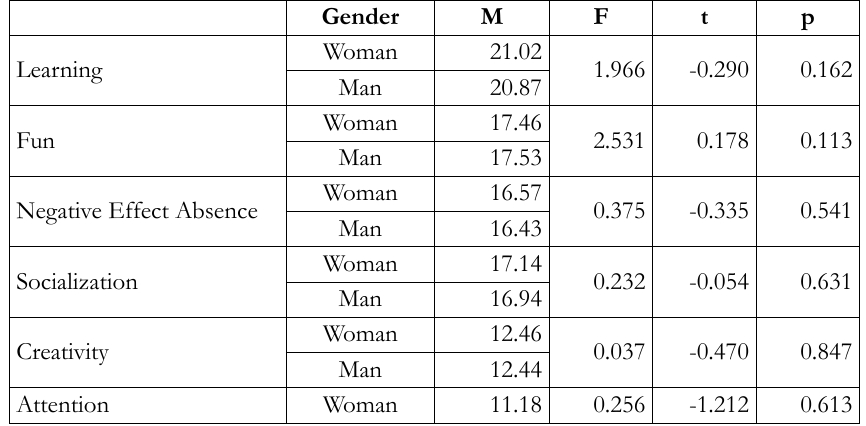
Table 4. Student’s t test results according to the gender of the participants